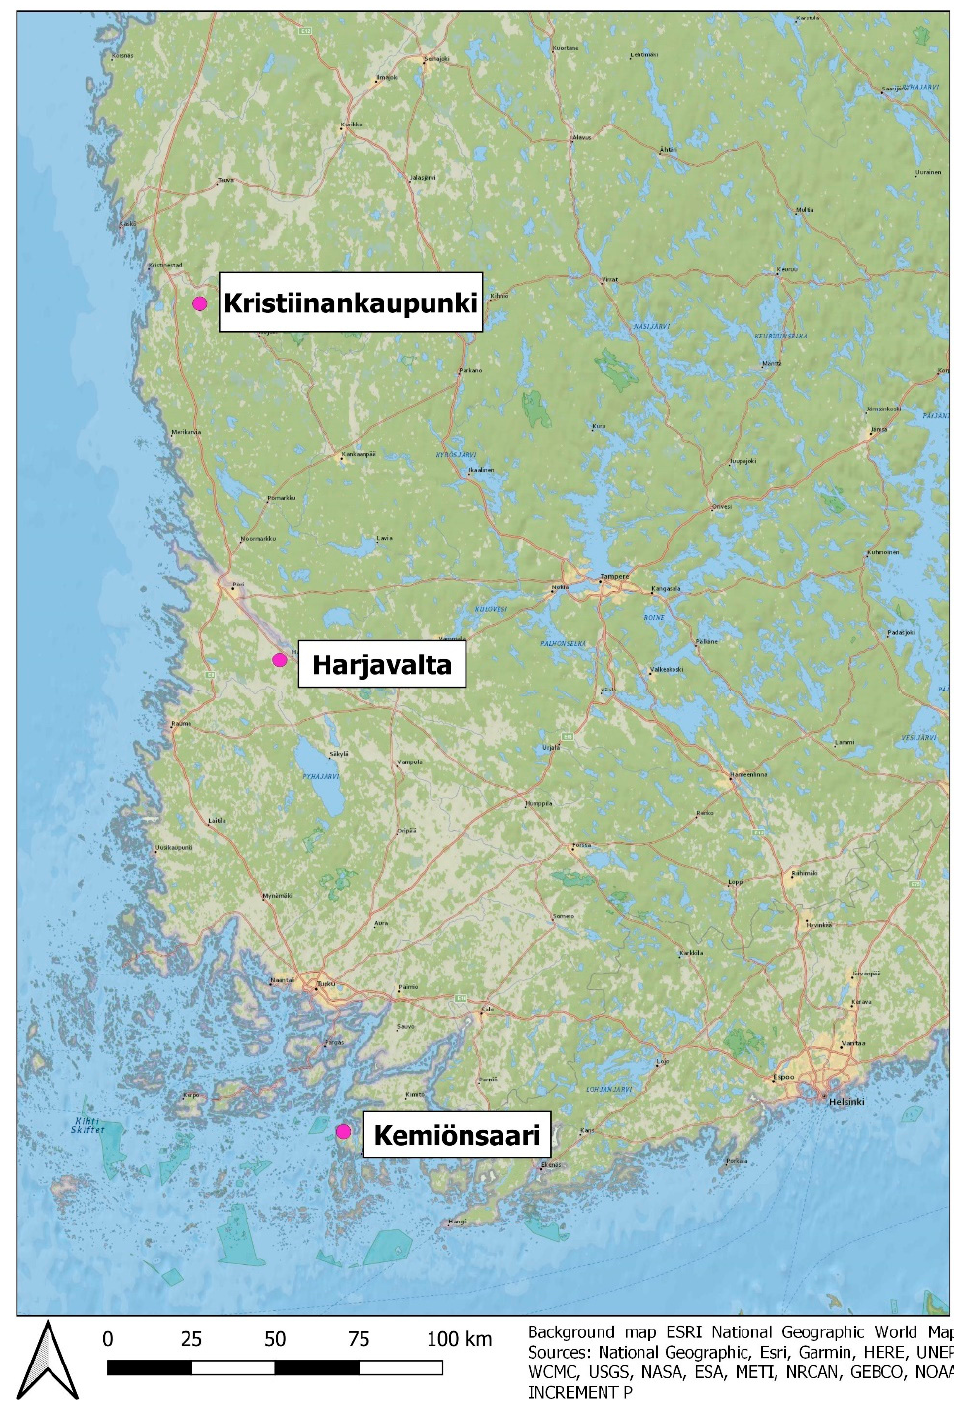
Figure 4. The Kiukainen culture areas that were selected for closer review. The Kiukainen sites in Kemiönsaari are located on large rocky islands in the archipelago area (Figure 5). Only the northernmost site of Näset was located on the shore of a smaller island. The sites are oriented towards the east because it afforded the best shelter from the western winds and better landing possibilities while navigating at sea (Figure 6). Since Kiukainen culture. Landing on sandy beaches must have been easier than landing on a rocky shoreline, which could be one explanatory factor for site locations in the